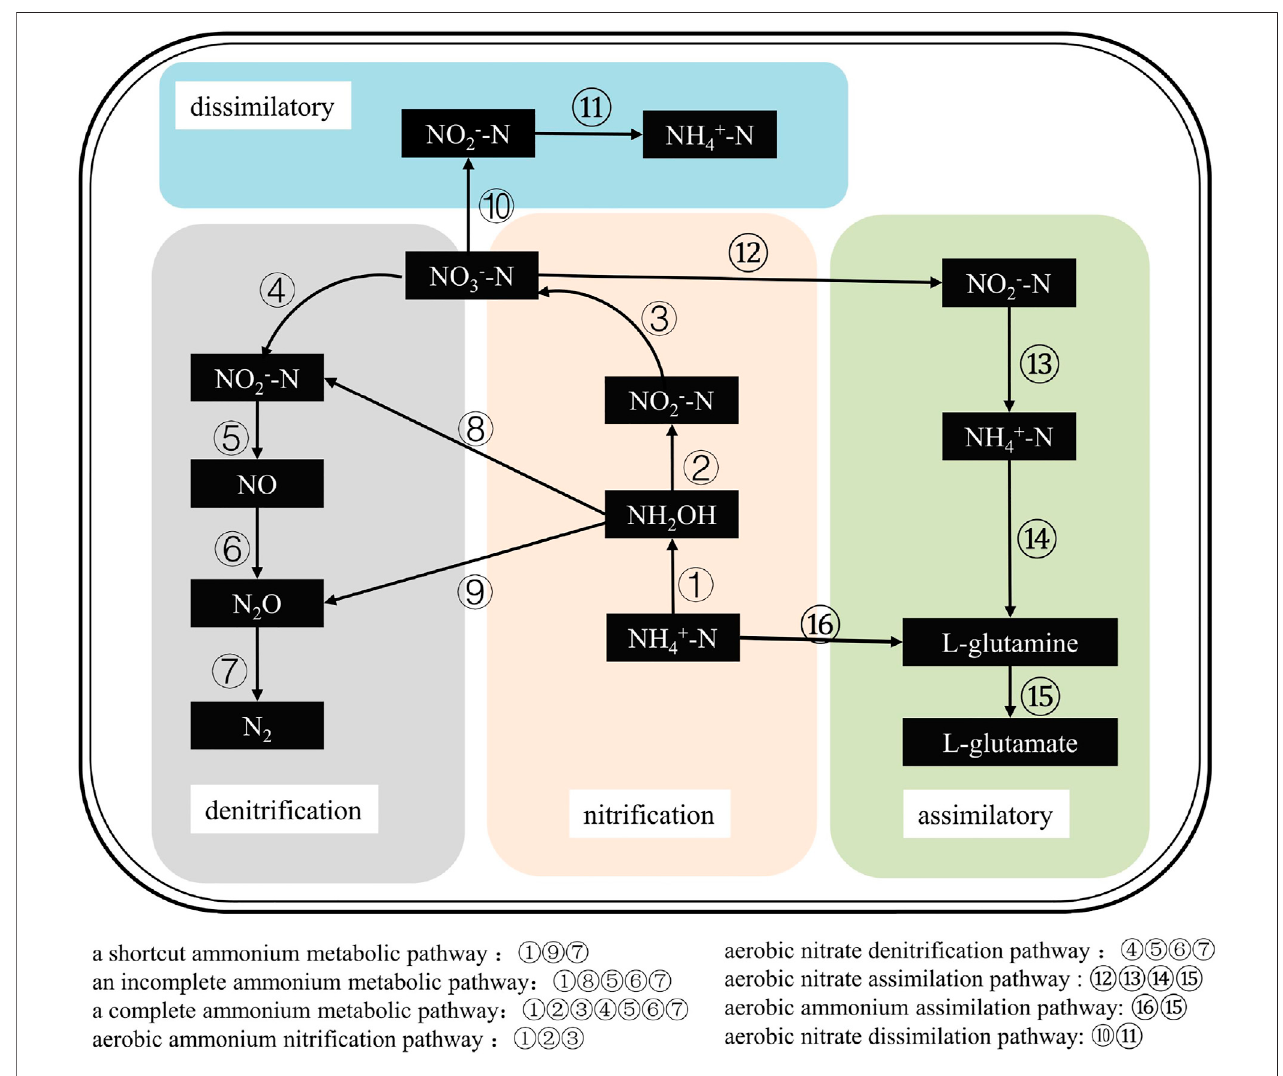
FIGURE 2 | The nitrogen conversion pathways of HNADs, which include mainly ammonia nitri fi cation, nitrate denitri fi cation, nitrite incomplete denitri fi cation, and nitrate assimilation/dissimilation under aerobic conditions.